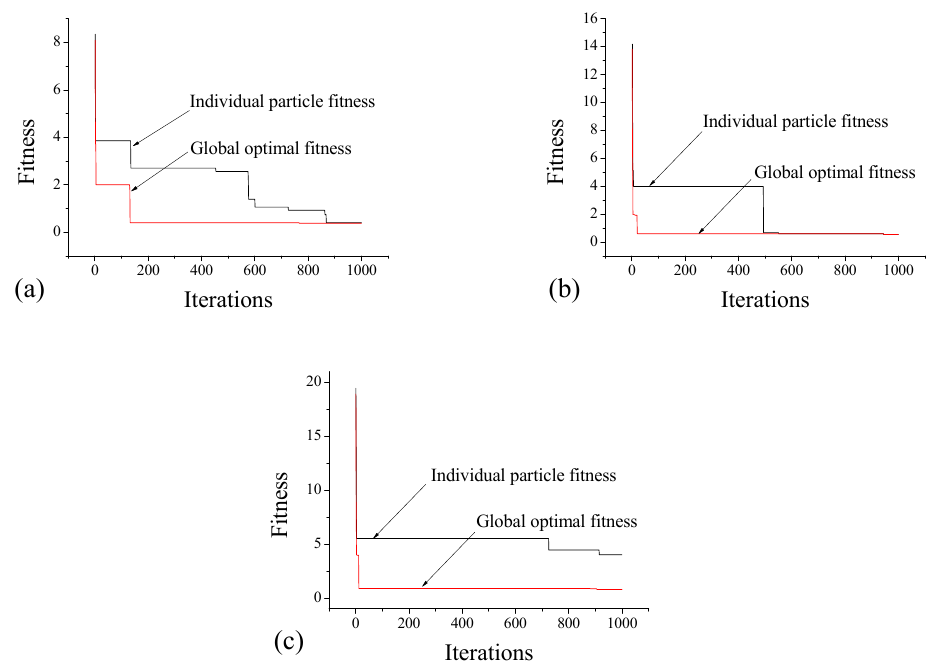
Figure 13. Fitness curves of individual representative particles and global best solutions for ( a ) case 7; ( b ) case 8; and ( c ) case 9 as indicated in Table 6.